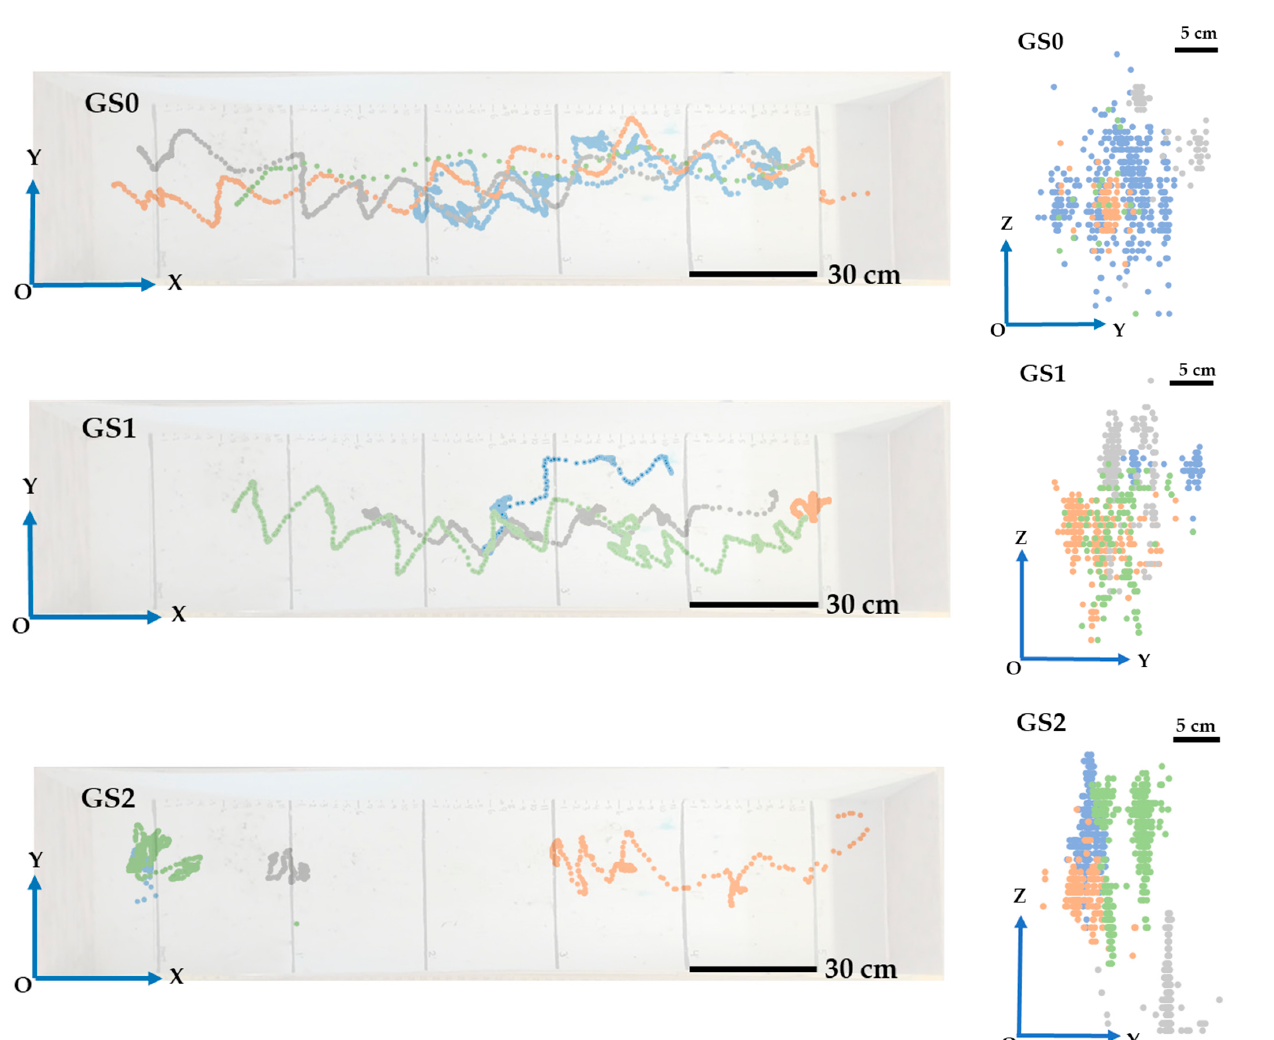
Figure 6. Movement trajectory of broilers with different gait scores. ( Left ) on XY plane; ( Right ) on YZ plane.